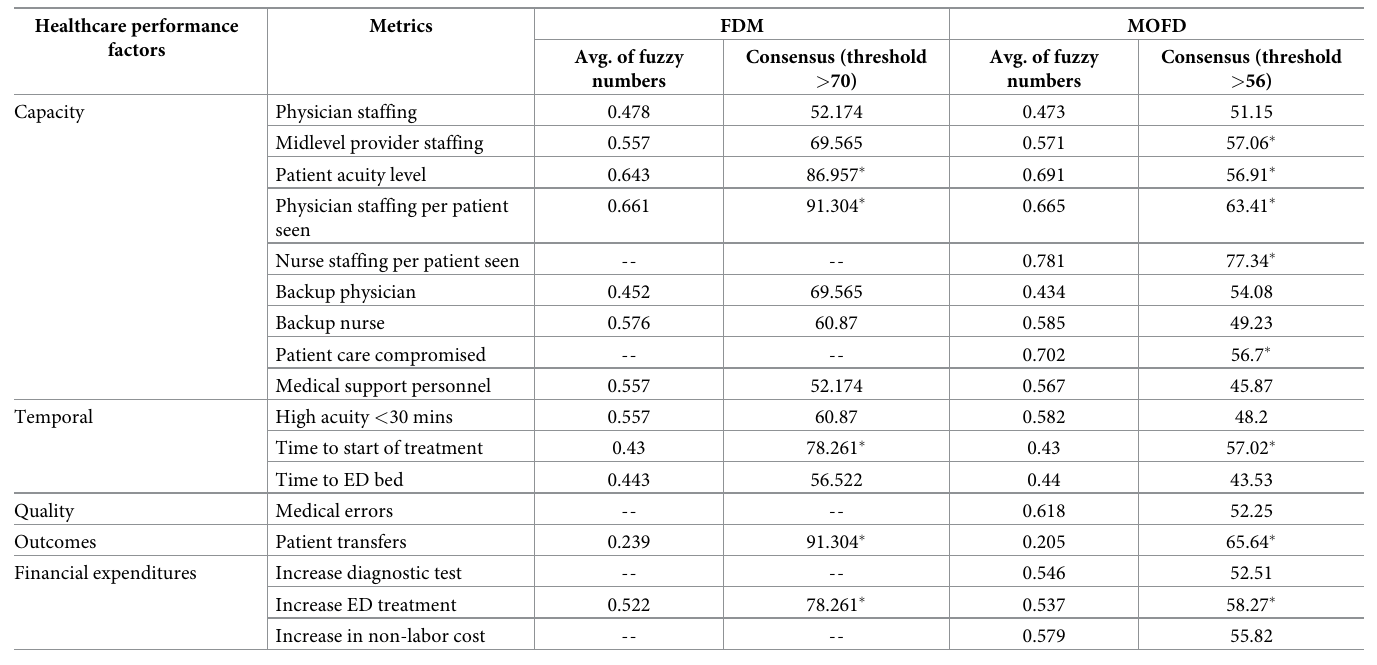
Table 4. Second-round results for FDM & MOFD method.